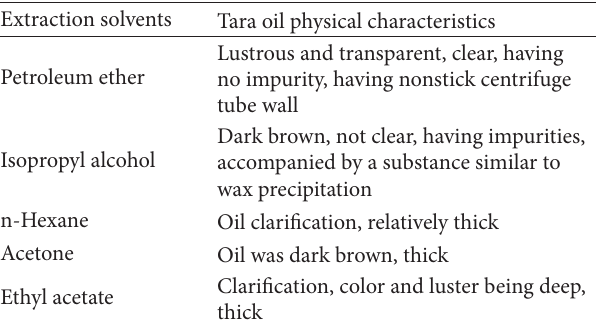
Figure 1: Tara seed oil yields with different organic solvents. Samples of dry tara powder (10g, 60–80 mesh) were extracted with different organic solvents. The ultrasonic extraction was performed for 45 min at 250 W and 30 ∘ C. Table 1: Physical characteristics of tara seed oils extracted using different